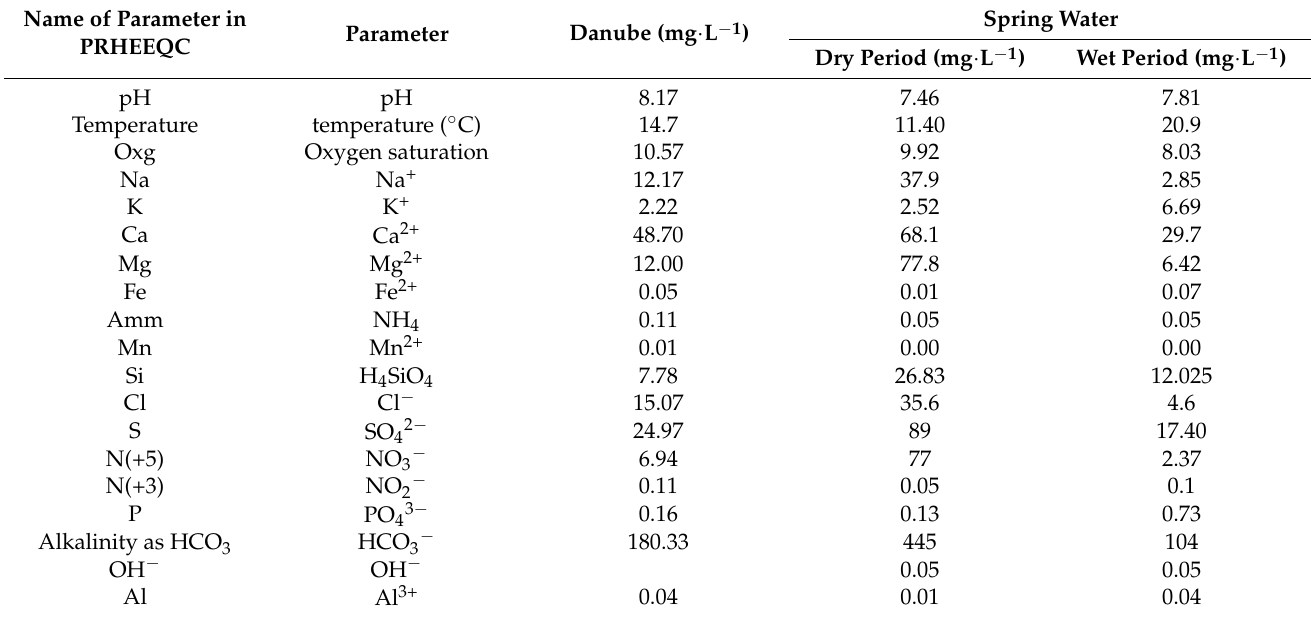
Table 1. Input data of water for geochemical modeling.